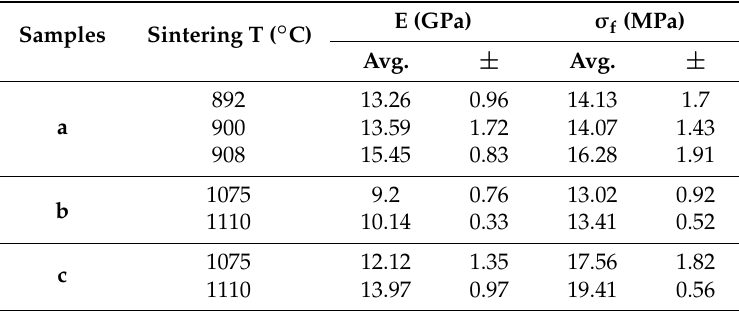
Table 8. Average values and standard deviation of the Young modulus E (GPa) and flexural strength σ f